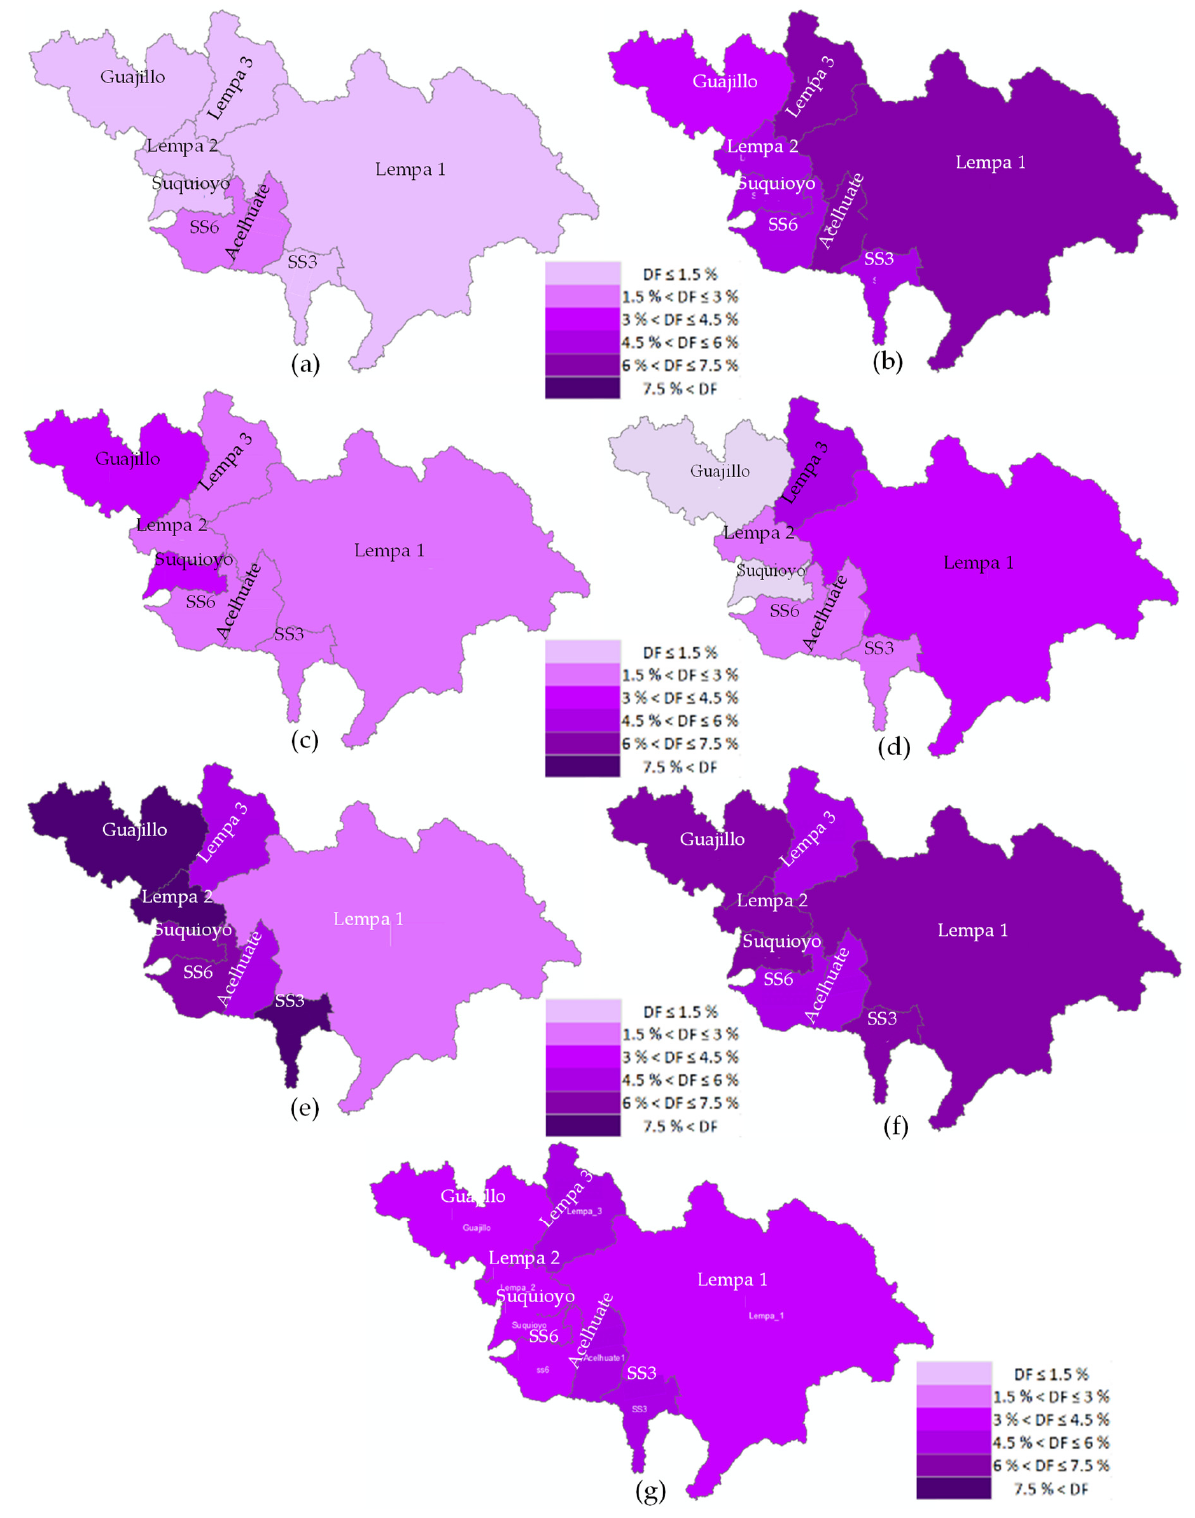
Figure 5. Drought Frequency ( D F ) maps based on SEDI06 in eight sub-basins of Lempa River basin. Considering six quin- Figure 5. quennials, and the overall period: ( a ) 1981 to 1985; ( b ) 1986 to 1990; ( c ) 1991 to 1995; ( d ) 1996 to 2000; ( e ) 2001 to 2005; ( f ) 2006 to 2010; ( g ) 1980 to 2010 (31